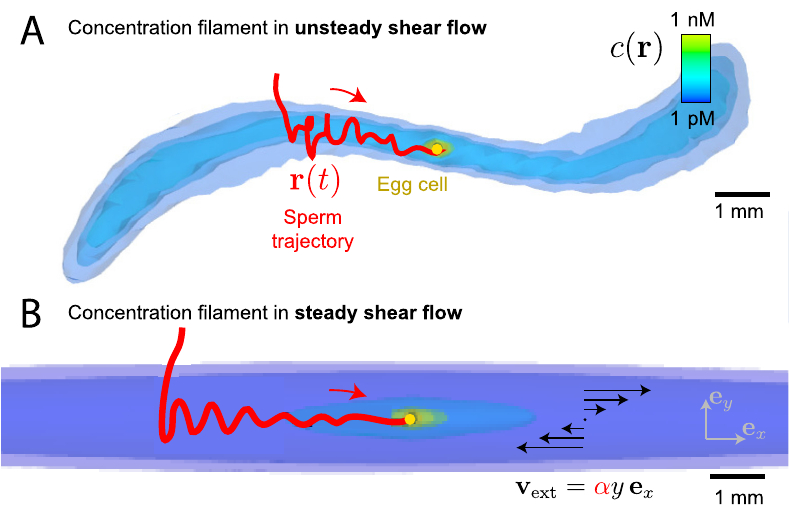
Fig 1. Sperm chemotaxis in external flow. (A) Simulated, three-dimensional concentration field c ( r ) of chemoattractant released from a freely-rotating, spherical egg (yellow sphere) suspended in unsteady shear flow as a model of small-scale turbulence. An exemplary simulated sperm cell (trajectory in red) finds the elongated concentration filament by chance and subsequently ‘surfs’ along the filament by chemotaxis. (B) Same as (A), but for the prototypical idealization of simple shear flow v ext ( r ) = α y e x accounting for convection and co-rotation by the external flow. We obtain a generic form of the concentration filament, Eq (1), and characterize surfing along the filament analytically as a damped oscillation. Parameters correspond to sea urchin A. punctuala , assuming continuous release of chemoattractant at constant rate _ Q ¼ 0 : 46 fmol min (cid:0) 1 for an exposure time t max = 6 min. Constant shear rate α = 0.17 s − 1 in (B), corresponding to root-mean-square shear rate of (A). Same color-code for concentration in (A) and (B), but different level sets. We use a generic theoretical description of helical sperm chemotaxis, see Methods and materials for details (helix radius r 0 = 7 μ m not visible at length-scale of figure). Rotating views of the 3D images are provided as S1 and S2